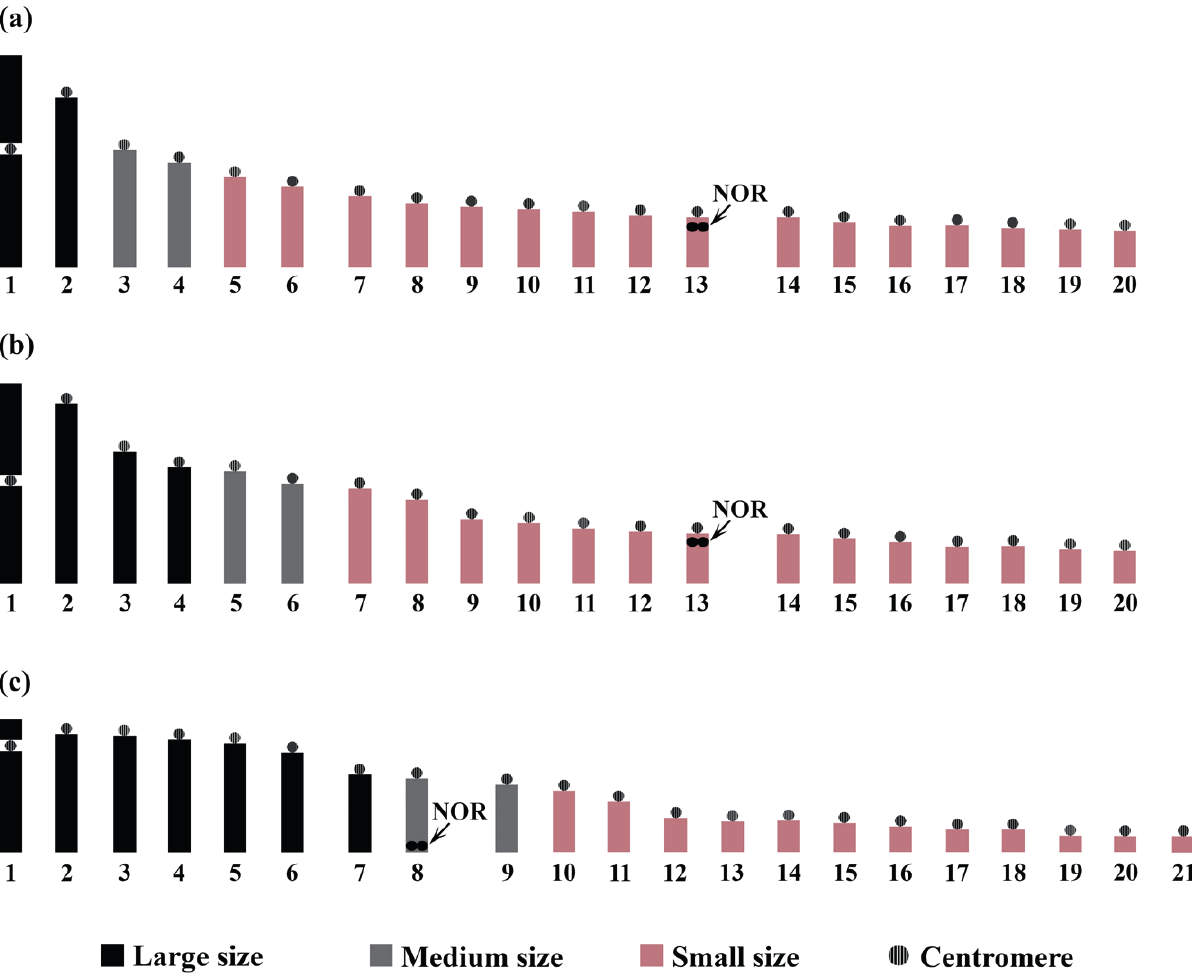
Figure 4. Standardized idiogram of D. hangseesom (a), D. siamensis (b) and D. melanostictus (c). Arrows indicate nucleolar organizer regions